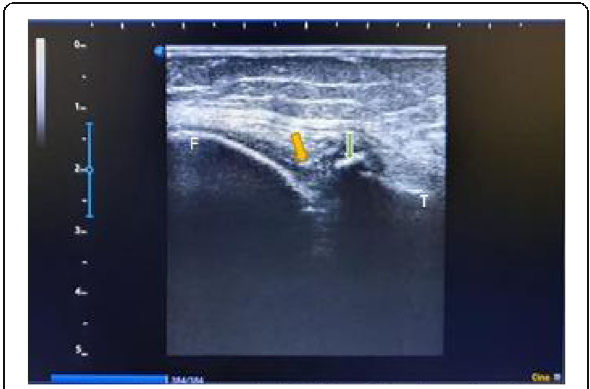
Fig. 2 MSUS; longitudinal scan shows several thin hyperechoic spots in the fibrocartilage of right medial meniscus or punctate pattern (pattern II) in the right knee joint characteristic of CPPD deposition. Knee, lateral longitudinal scan showing distal femur (F) and proximal tibia (T) with hyperechoic CPPD deposits embedded in the substance of the lateral meniscus (yellow arrow) and large osteophyte (green